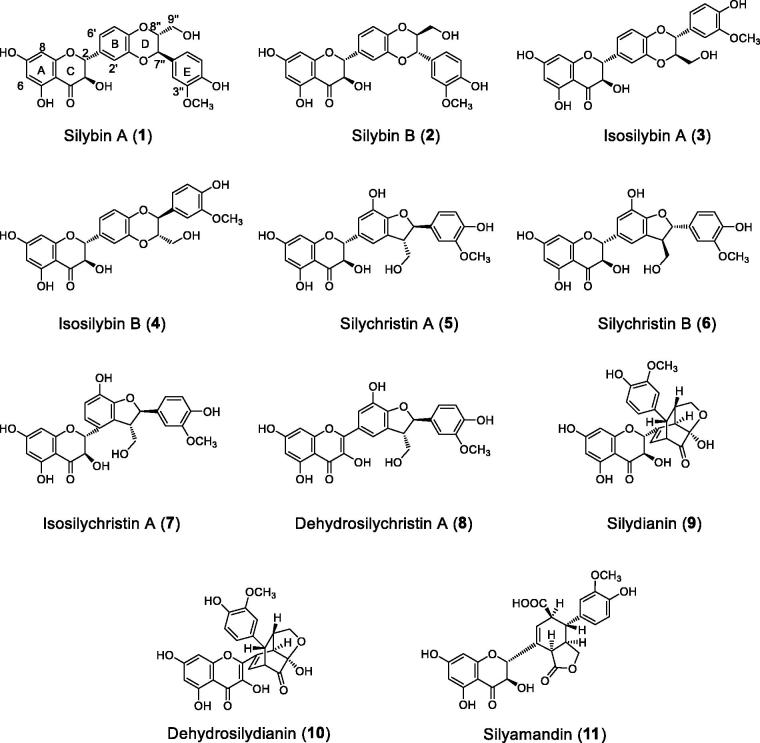
Structures of compounds 1–11.